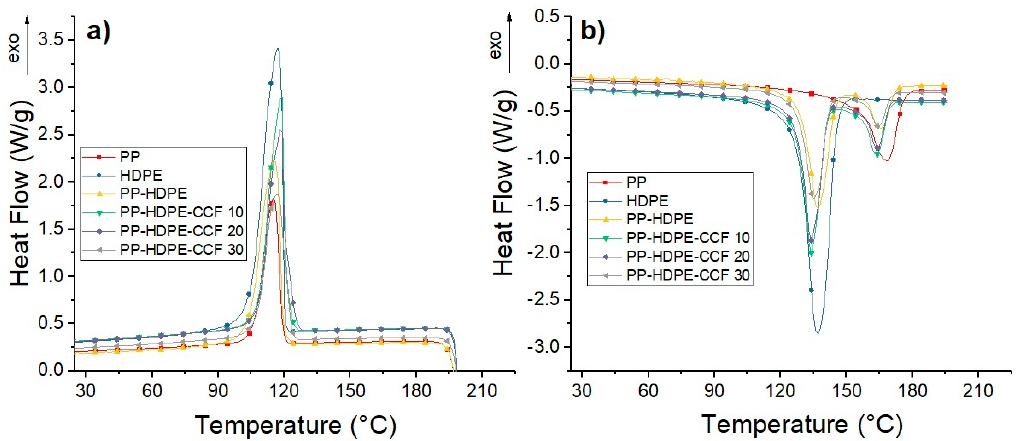
Figure 7. ( a ) Cooling and ( b ) Second heating DSC curves of PP, HDPE, PP-HDPE blend, and their biocomposites.